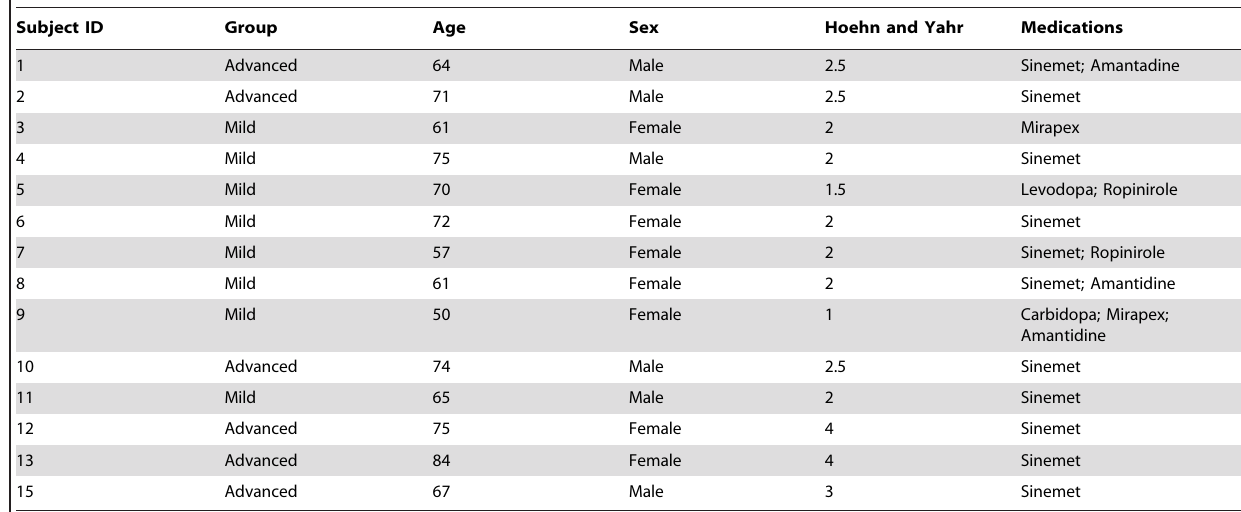
Table 1. Parkinson’s diseased subjects’ characteristics.